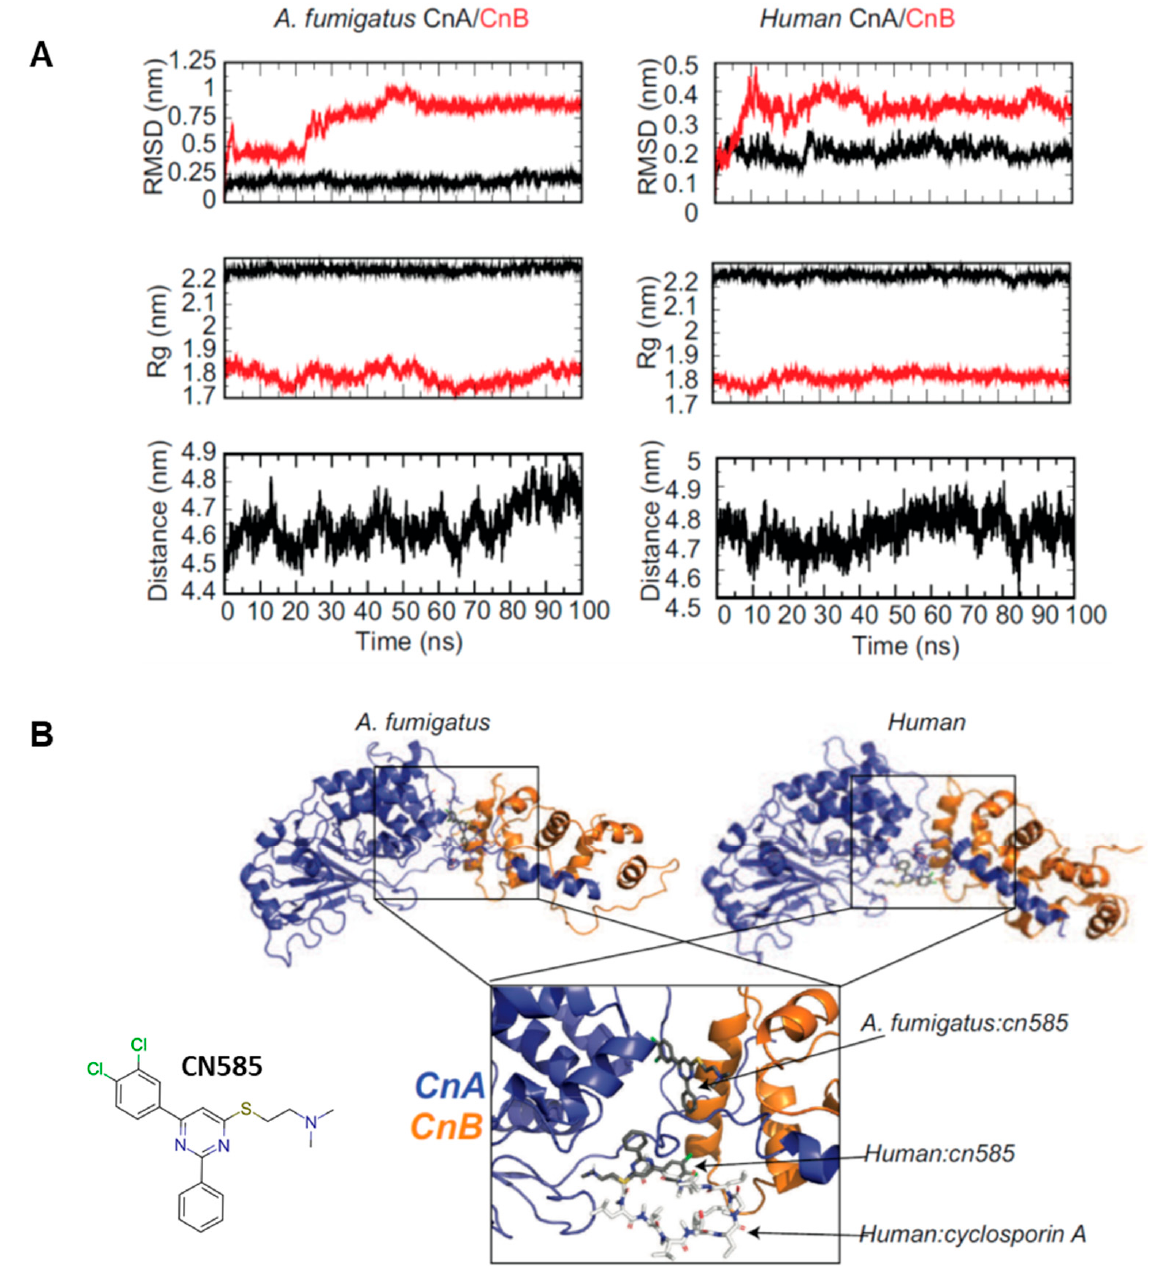
Figure 5. Molecular dynamics simulation and docking of A. fumigatus and human CnA/CnB to CN585. ( A ) MD simulation analysis showing the RMSD (top), Rg (middle), and COM of CnA to CnB (bottom) of CnA/CnB during the simulation. ( B ) Docking model of A. fumigatus CnA/CnB:CN585 (left—CnA (blue) and CnB (orange) compared to human CnA/CnB:CN585 (right—CnA (blue) and CnB (orange). Overlay of the docking poses of CN585 and CsA is shown at the bottom. Labels provided for clarity.